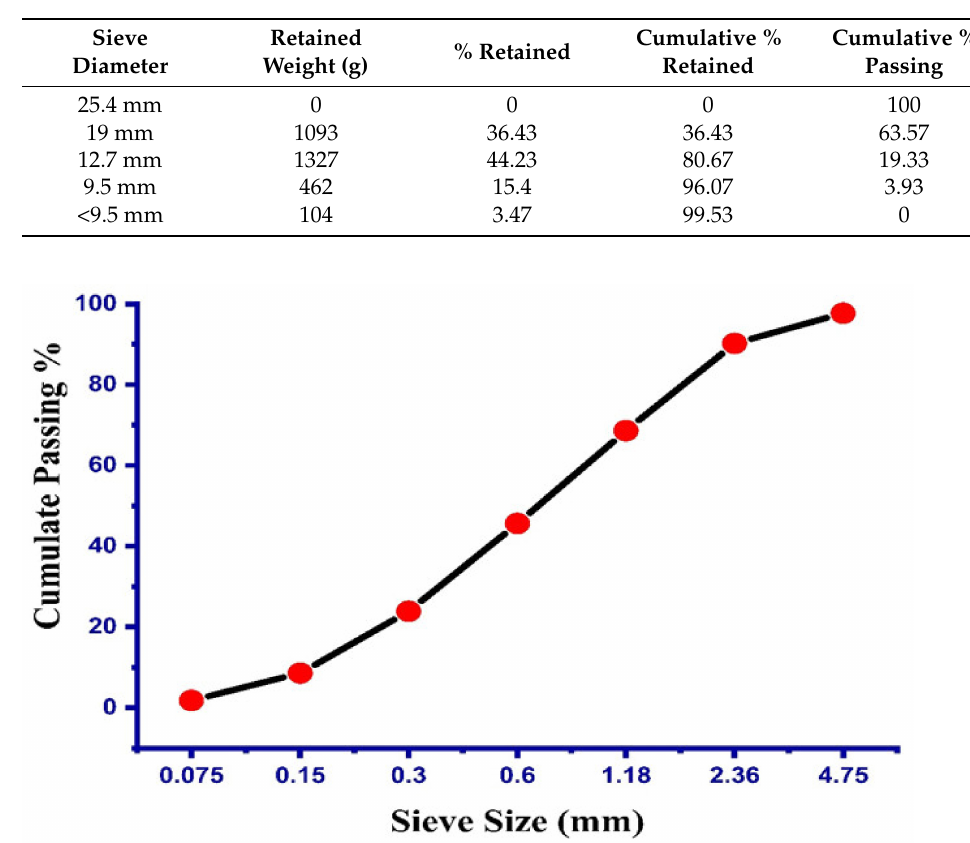
Figure 1. Grain size curve of fine aggregate.